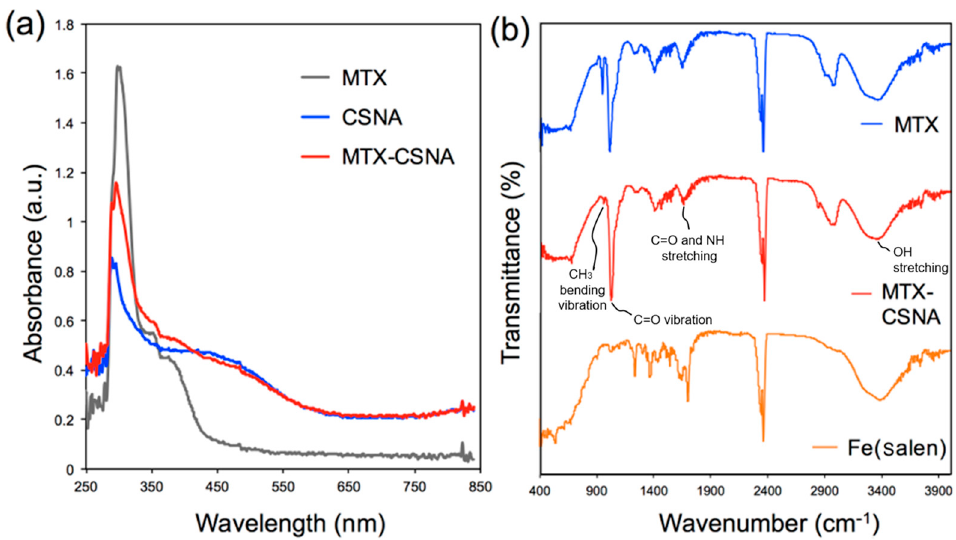
Figure 2. Optical characterization of MTX-CSNA NPs. ( a ) UV-vis absorbance and ( b ) FT-IR spectra, determining the successful conjugation of MTX drugs on the CSNA surface via CPy